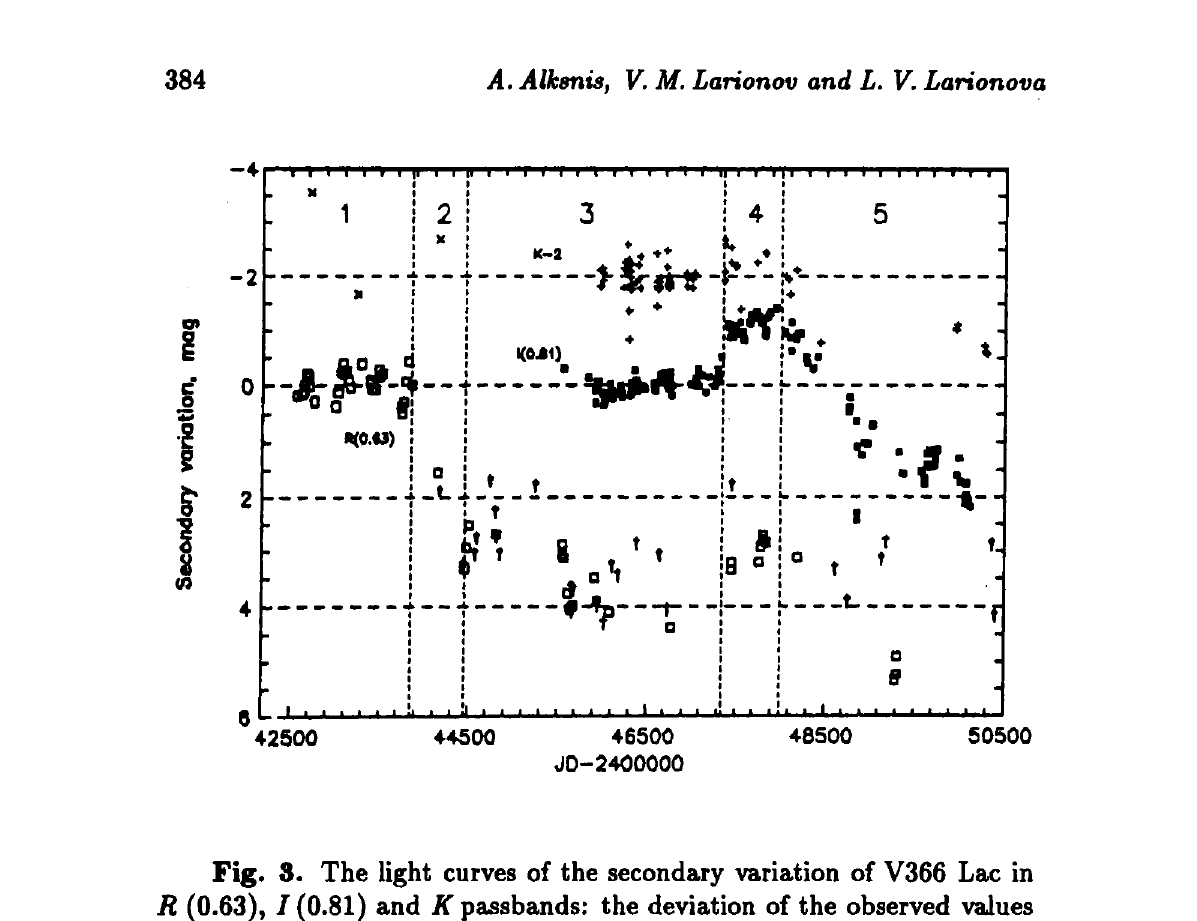
Fig. 3. The light curves of the secondary variation of V366 Lac in R (0.63), / (0.81) and K passbands: the deviation of the observed values from light curves of the periodic component versus time. The K values are reduced by 2 mag to separate K and I light curves. The designations are the same as in Fig. 1. The dashed vertical lines are time boundaries between the five main stages of secondary